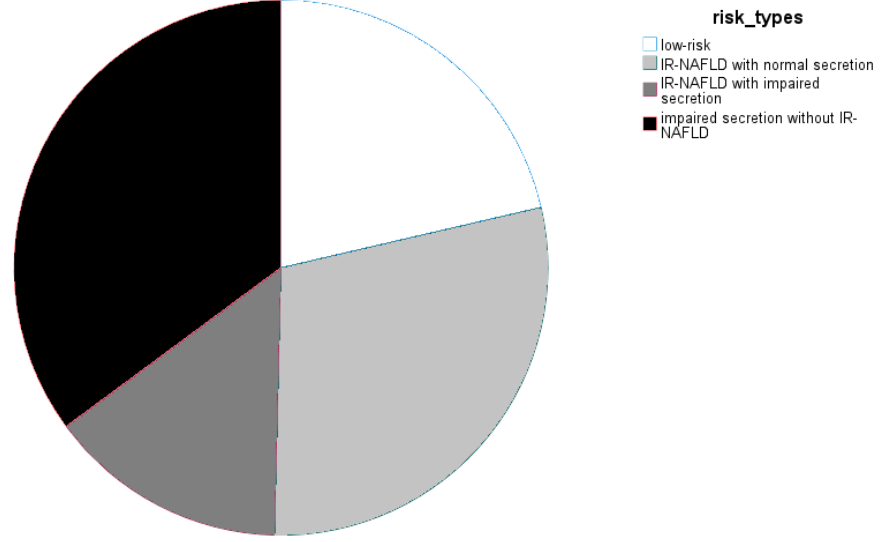
Figure 2. Cohort structure of OptiFiT according to the stratification schema, derived from the TULIP study.